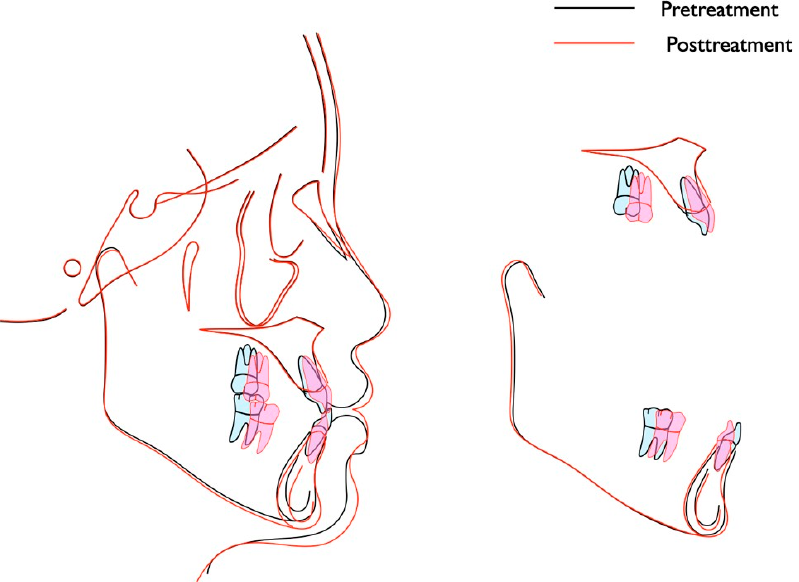
Figure 6. Case 1, Posttreatment panoramic radiograph and lateral cephalogram.